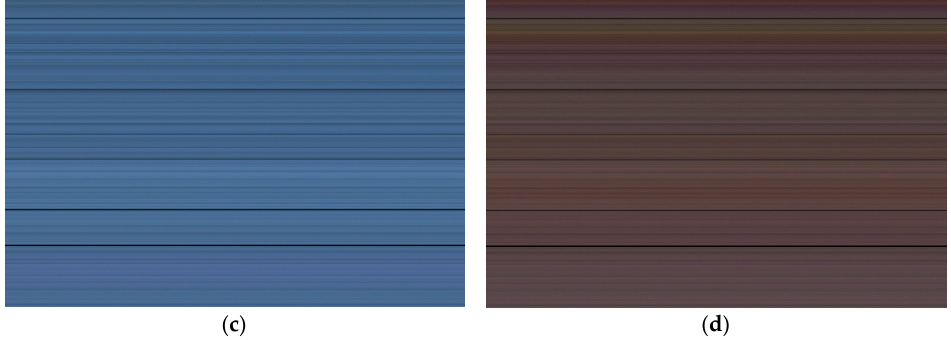
Figure 6. ( a ) A sub-image of “buildings” in visible bands (R: 650 nm, G: 560 nm, B: 480 nm); ( b ) A sub-image of “buildings” in NIR bands (R: 740 nm, G: 825 nm, B: 955 nm); ( c ) A sub-image of “the sky” in visible bands (R: 650 nm, G: 560 nm, B: 480 nm); ( d ) A sub-image of “the sky” in NIR bands (R: 825 nm, G: 912 nm, B: 976 nm).